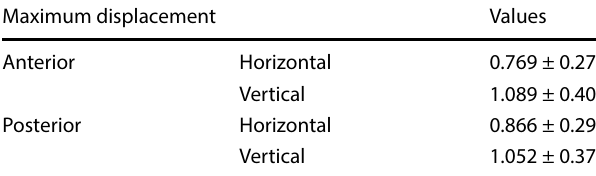
Table 4 Mean and standard deviation of the vertical and horizontal maximum displacement of both anterior and posterior part of the hyoid bone relative to the C3